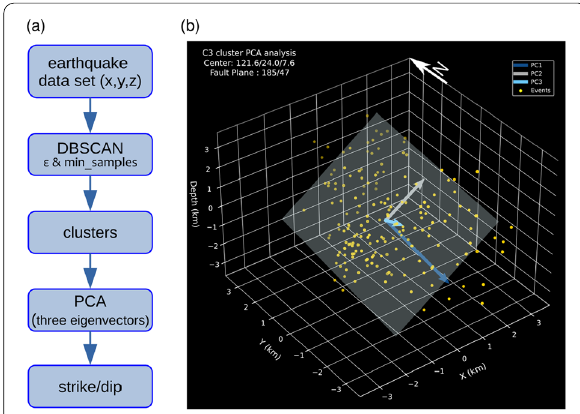
Fig. 3 a Flowchart of retrieving orientation of potential seismogenic structures through DBSCAN clustering and PCA. b Example cluster of C3 and the corresponding PCA, where events grouped by DBSCAN are denoted by circles, and thick colored arrows indicate eigen‑vectors scaled using corresponding eigen‑value, half transparent rectangles depict the PCA plan perpendicular to third eigenvector and centroid location of cluster and orientation (strike/ dip) of PCA plane are displayed top